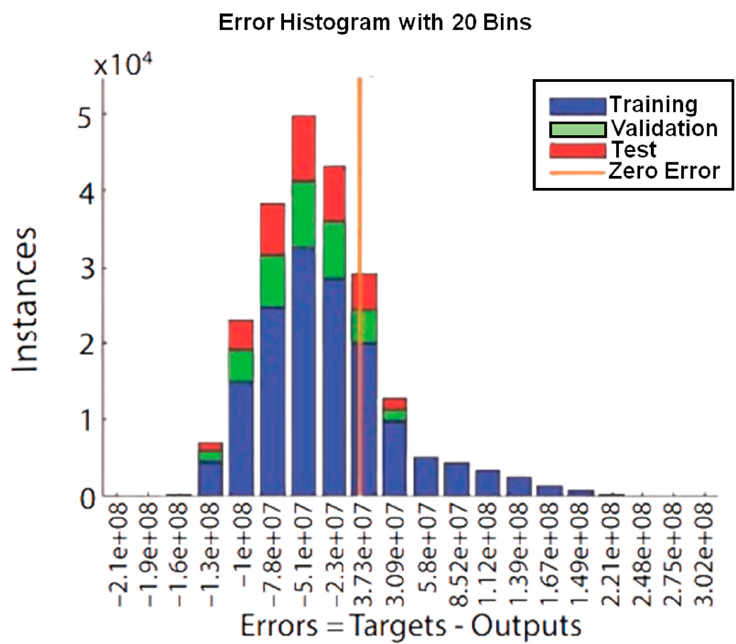
Figure 11. Rate of misclassification.